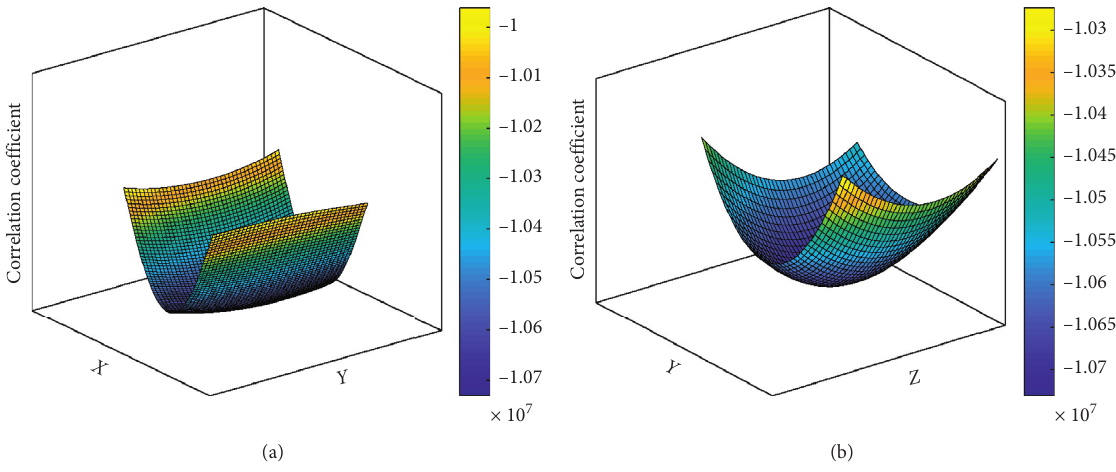
Figure 5: Optimisation function. (a) X–Y plane. (b) Y–Z plane.